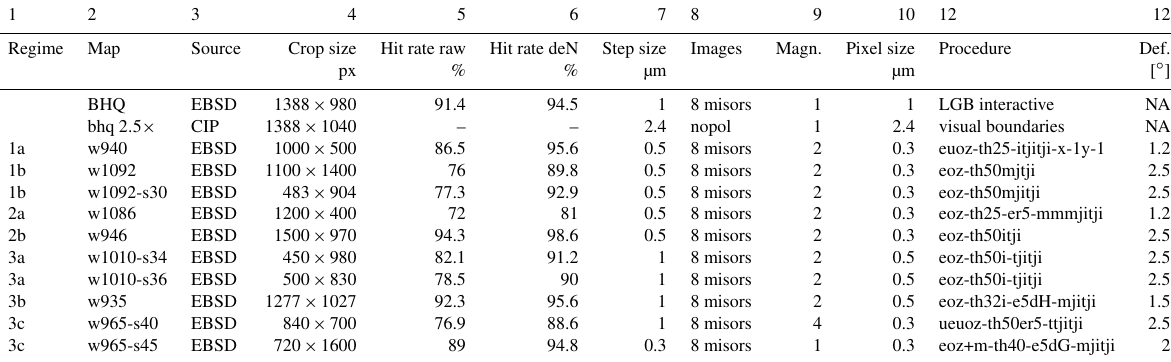
Table A2. Image processing and